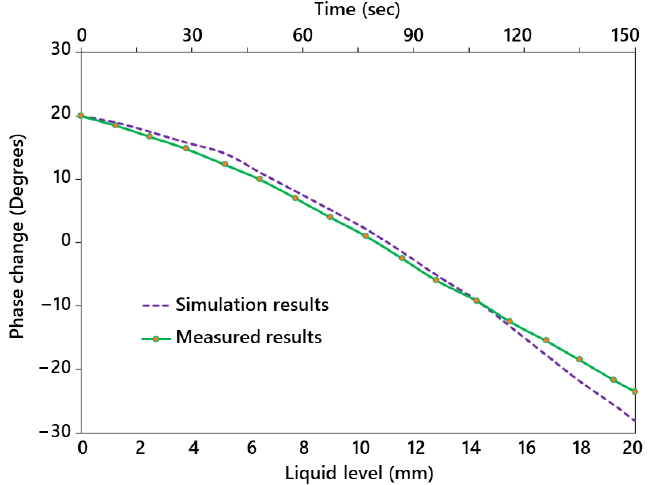
Figure 5. Sensor phase variation of the backscattered signal (measured) with respect to the liquid level, and a comparison of the simulated and measured phase